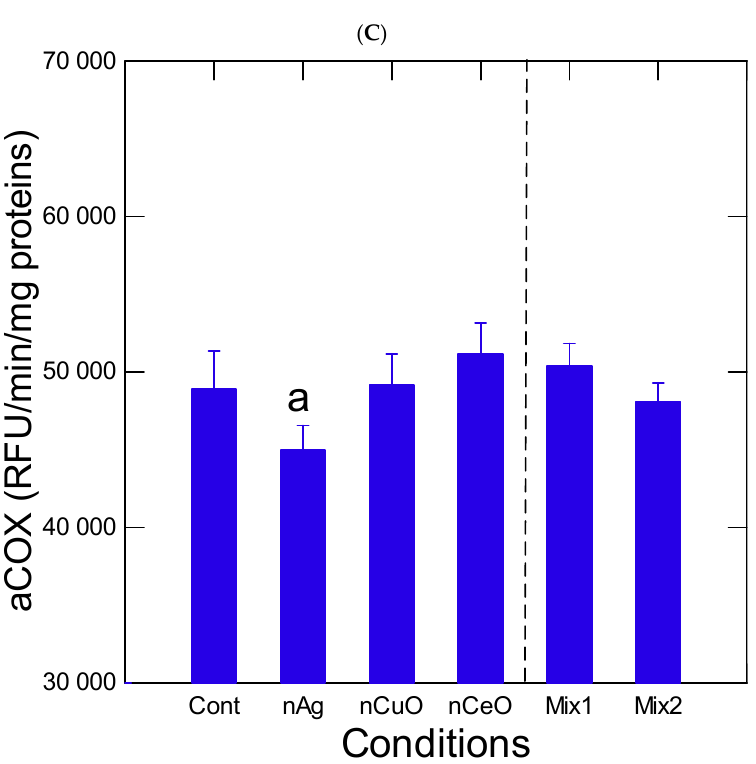
Figure 2. Oxidative stress in the liver of trout exposed to the nanoparticles. Oxidative stress was determined by labile Zn ( A ), LPO ( B ) and aCOX ( C ). The data represent the mean with the standard error. The letter a indicates significance relative to controls, b significance relative to Mix1 and c relative to Mix2.